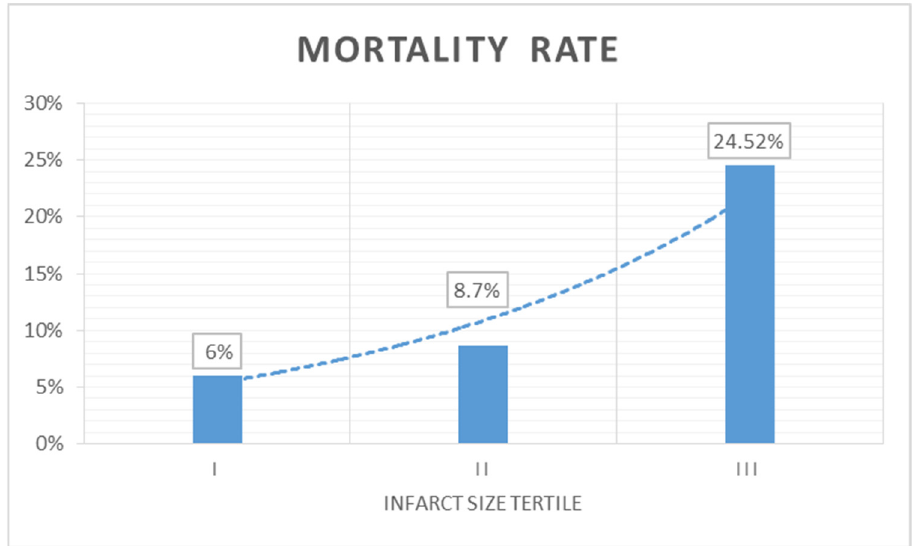
Figure 2. Two-year mortality rates and trend in the analyzed study group.